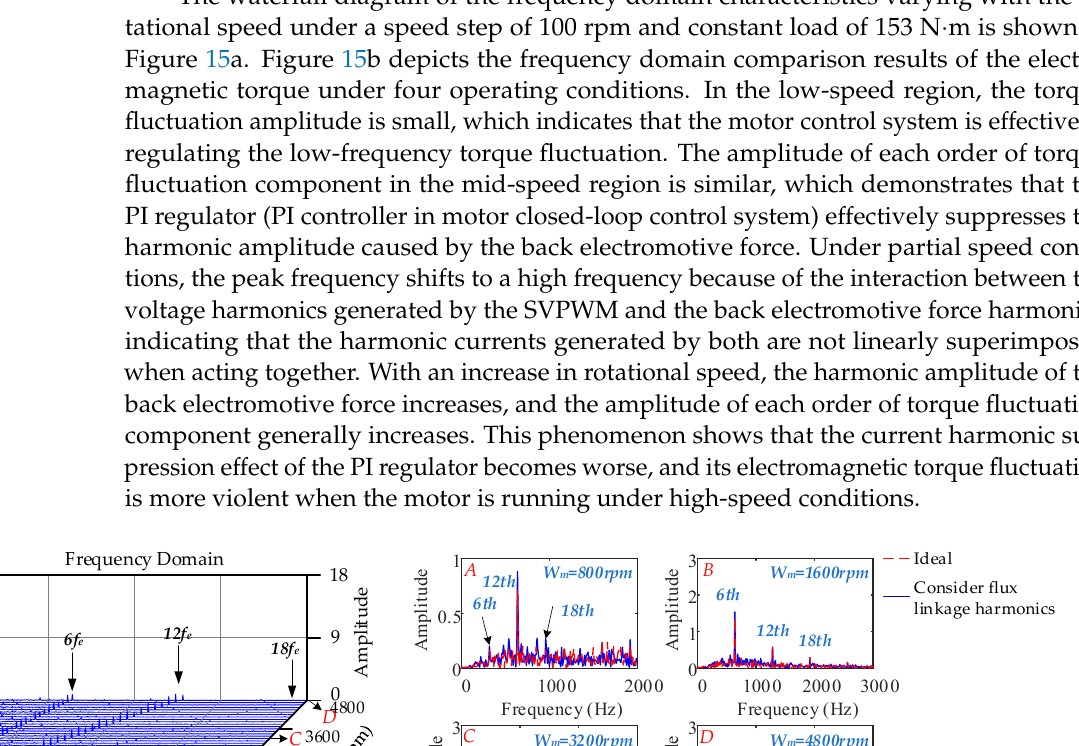
( b ) Figure 16. Frequency domain results of electromagnetic torque under different loads: ( a ) waterfall diagram of electromagnetic torque; ( b ) comparison results of electromagnetic torque. 4.4. Consideration of the Cogging Torque 4.4.1. Constant Speed, Constant Load Condition The influence of the cogging torque on the accuracy of the motor and control system was determined by introducing mathematical equations. The parameters are listed in Ta ‐ ble 5.